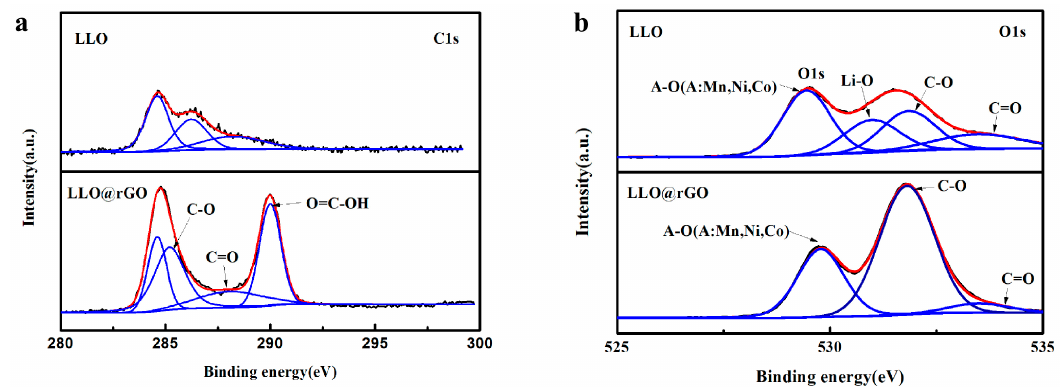
Figure 6. Resolution X-ray photoelectron spectroscopy (XPS) spectra of ( a ) C1s and ( b ) O1s of LLO and LLO@0.5%rGO.